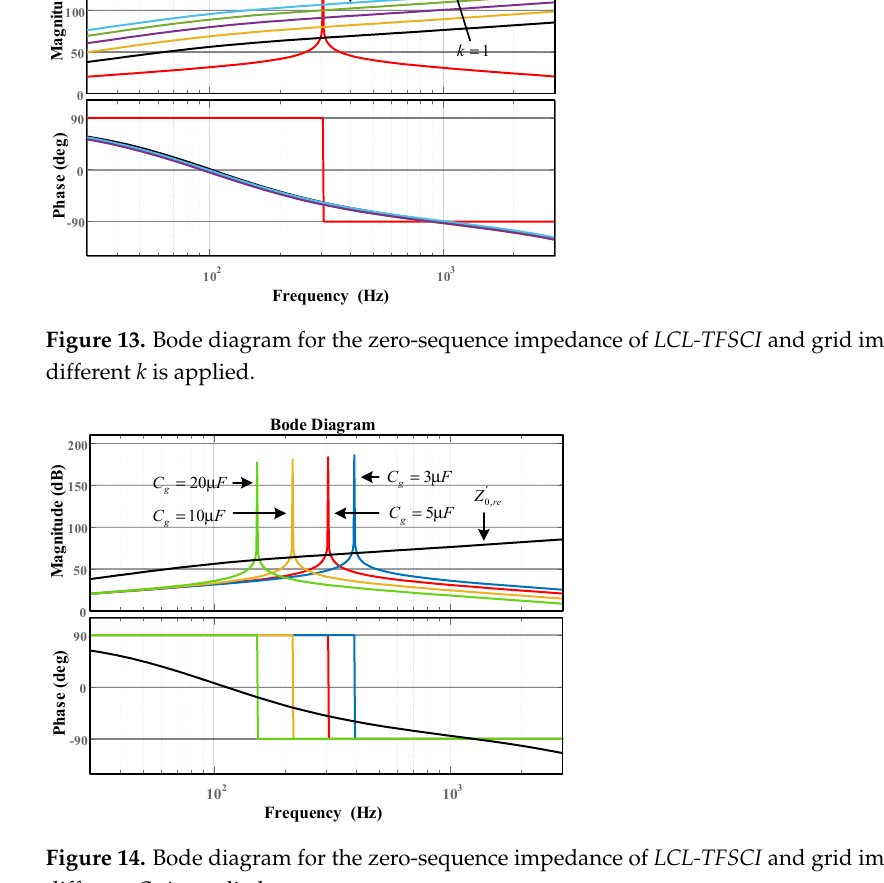
( b ) Figure 12. Bode diagram for the reshaped impedance of LCL-TFSCI and the grid with parallel com- pensation capacitors. ( a ) Positive-sequence and negative-sequence; ( b ) Zero-sequence. 4.2. Parameter Analysis In order to determine the range of parameters for the proposed oscillation damping controller and verify its adaptability to the changes of grid parameters, the effect of im- pedance reshaping will be discussed in this section when different damping controller gain k and the parallel compensation capacitors C g are applied by taking the inverter zero-